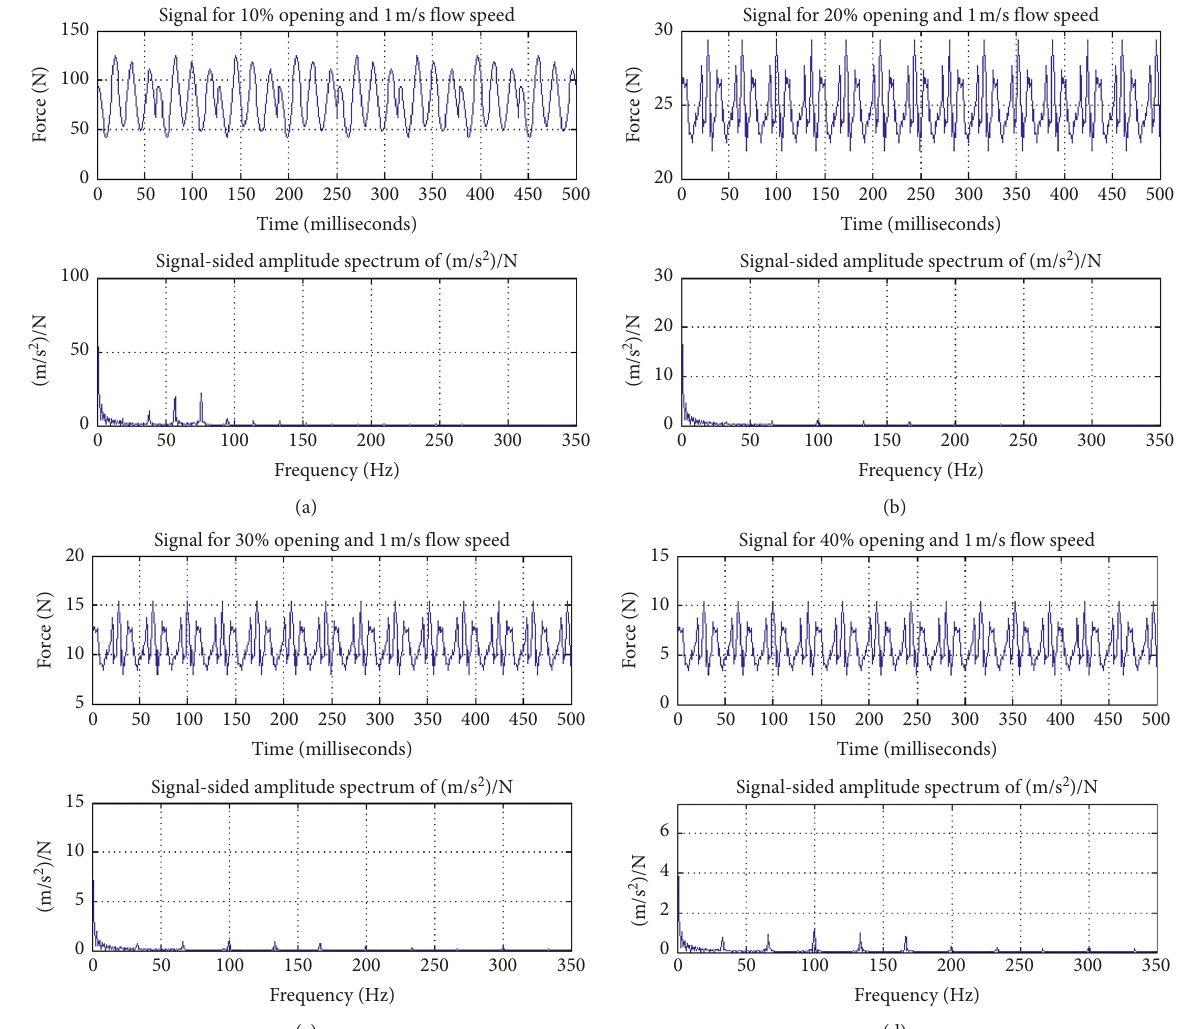
Figure 7: Flat plug as represented theoretically at a flow velocity of 1m/s under different valve openings. (a) 10% valve opening; (b) 20% valve opening; (c) 30% valve opening; (d) 40% valve opening.